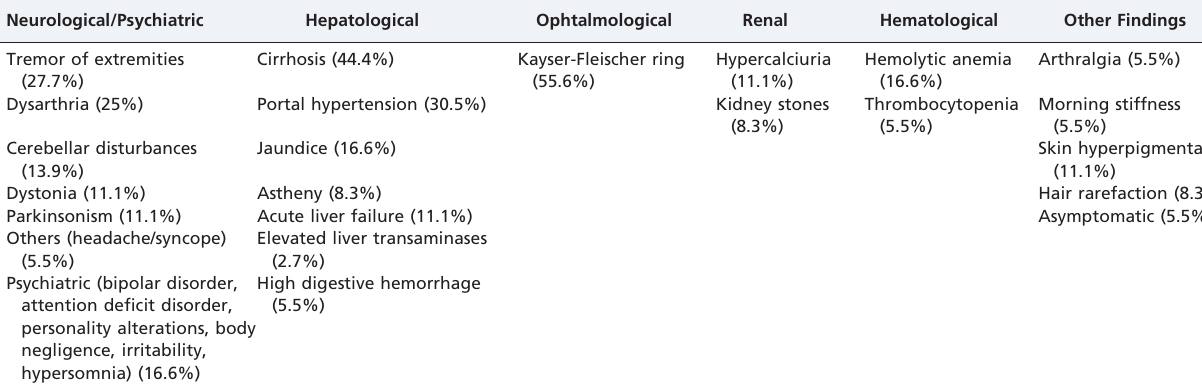
Table 1 - Clinical-Laboratory Findings (n= 36).